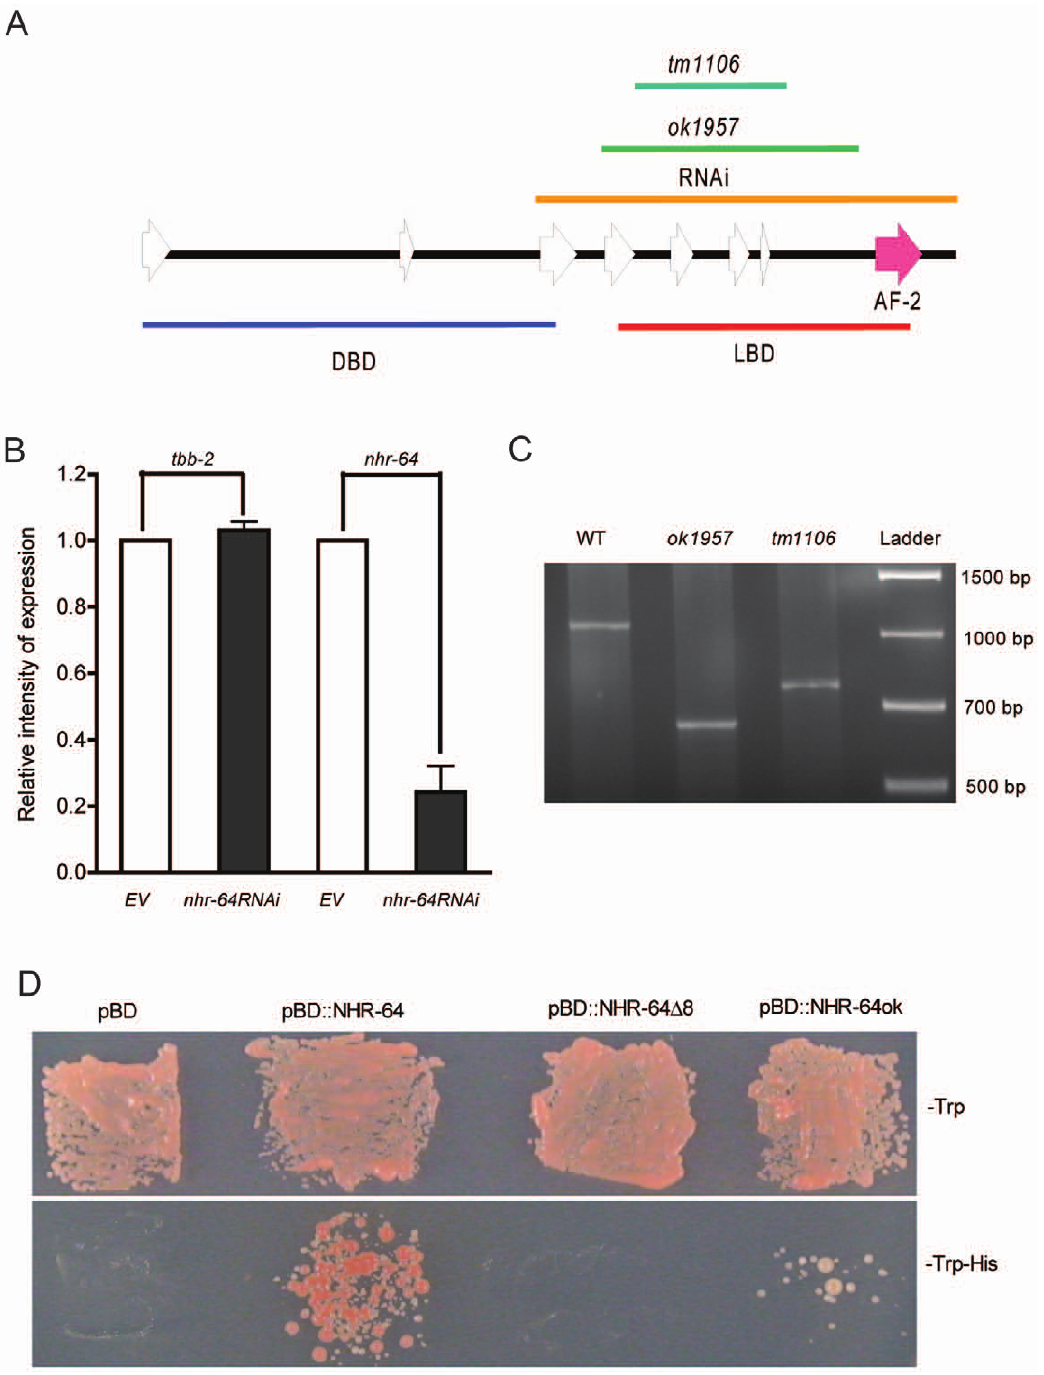
Figure 4. Partial suppression and partial transcriptional activation activity of an nhr-64 deletion mutant. (A) Simplified scheme of nhr- 64 gene structure. White arrows are exons and black lines are introns. DBD: DNA binding domain; LBD: ligand binding domain. RNAi: RNA interference; AF-2: transactivation domain. (B) The expression of nhr-64 in L4s WT animals treated with nhr-64RNAi or EV control. Data were the average of two independent biological repeats and quantified with GeneSnap software. (C) The transcripts of nhr-64 in WT (1110 bp), nhr- 64(ok1957) mutation (665 bp) and nhr-64(tm1106) mutation (771 bp). Ladder: 1 kb DNA ladder (Fisher Scientific). (D) Demonstration of transcriptional activation activity of WT and truncated NHR-64. Deletion of exon 8 (pBD::NHR-64 D 8) abolished the ability of NHR-64 to grow on selective SD medium without both tryptophan and histidine (SD-trp-his), indicating lack of transcriptional activation activity. The protein predicted to be synthesized by the nhr-64(ok1957) deletion mutant (pBD::NHR-64ok) retains the ability to grow on SD-trp-his selective medium, indicating residual transcriptional activation activity.